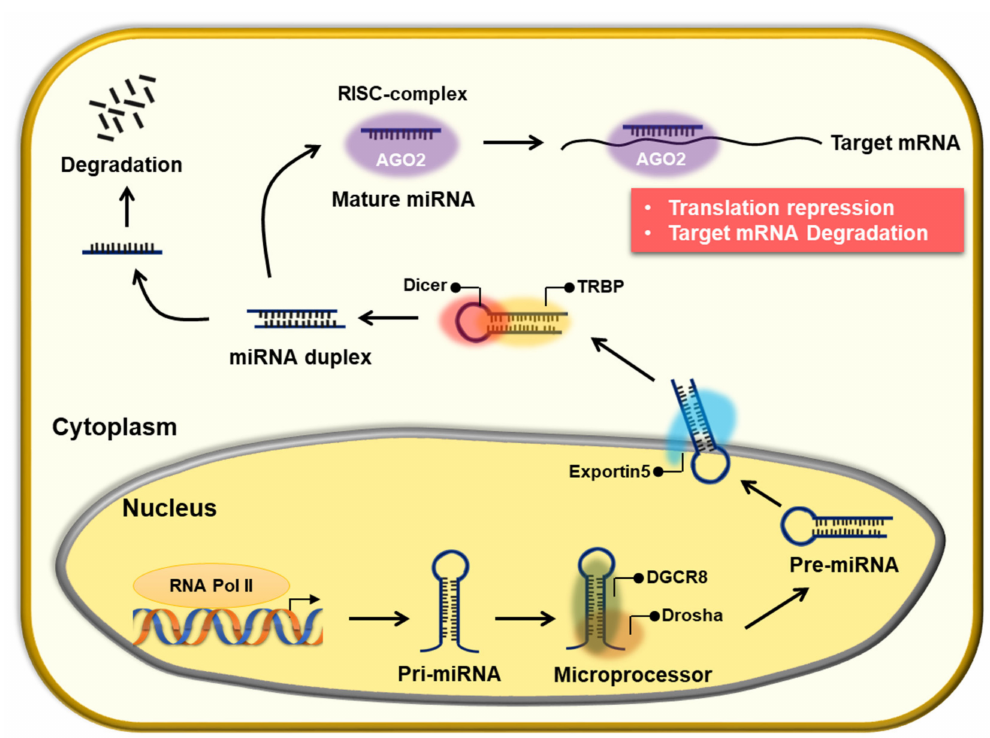
Figure 1. The canonical pathway of microRNA (miRNA) processing. In the nucleus, miRNA biogenesis is initiated with RNA polymerase II. Pri-miRNA with a hairpin transcript is further processed to pre-miRNA by the DGCR8/Drosha microprocessor complex. The pre-miRNA is then translocated to the cytoplasm through exportin-5. In the cytoplasm, multidomain human TAR element-binding protein (TRBP) recognizes pre-miRNA and is cleaved by Dicer, resulting in miRNA maturation. In the miRNA-duplex, only one strand is loaded onto the RNA-induced silencing complex (RISC) complex (including the AGO1-4 protein), which then binds to the complementary target gene. Finally, the target mRNA can be suppressed through translation repression or